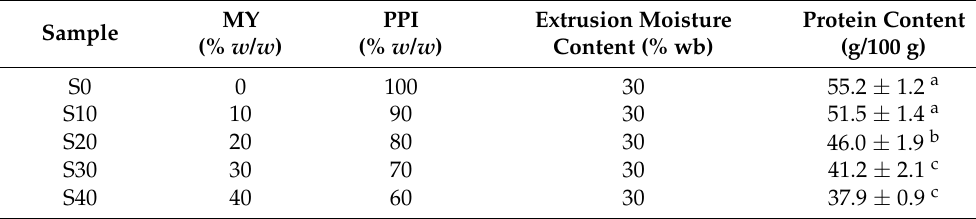
Table 1. Moisture and protein content of the samples before